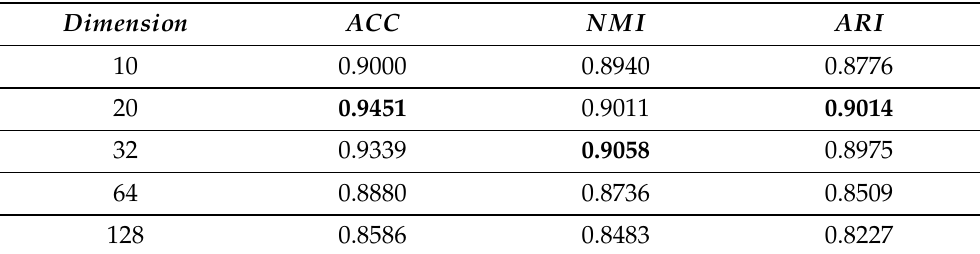
Table 4. Clustering results with different dimensions.